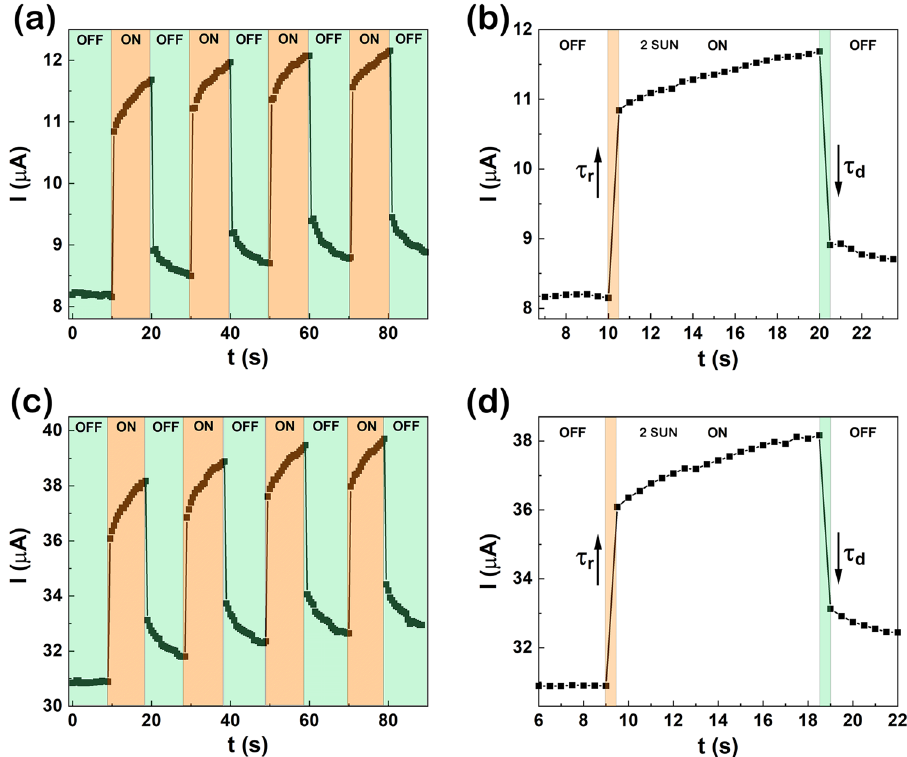
Figure 9. ( a , c ) Time-dependent photoresponse and ( b , d ) rise and decay time at 0.5 V applied bias during the light ON/OFF cycles on the photodetector systems: ( a , b ) CuO–ZnO_MIE_1 and ( c , d ) CuO–ZnO_MIE_2.